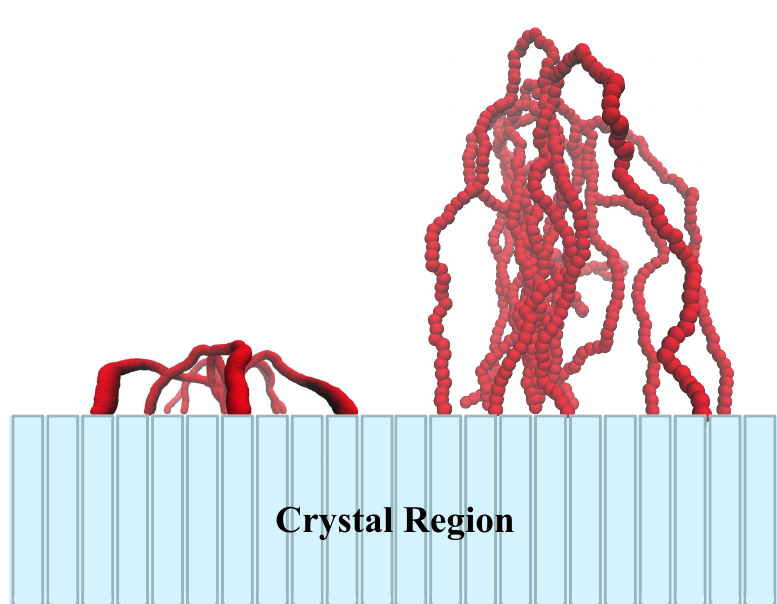
Figure 4. Conformational examples of tight folds ( L = 1, left ) and loose loops ( L = 8, right ) injecting outside the lamellar crystal. The conformations come from the important sampling by Monte Carlo in SCMFT. The blue bars represent the stems in crystal region.